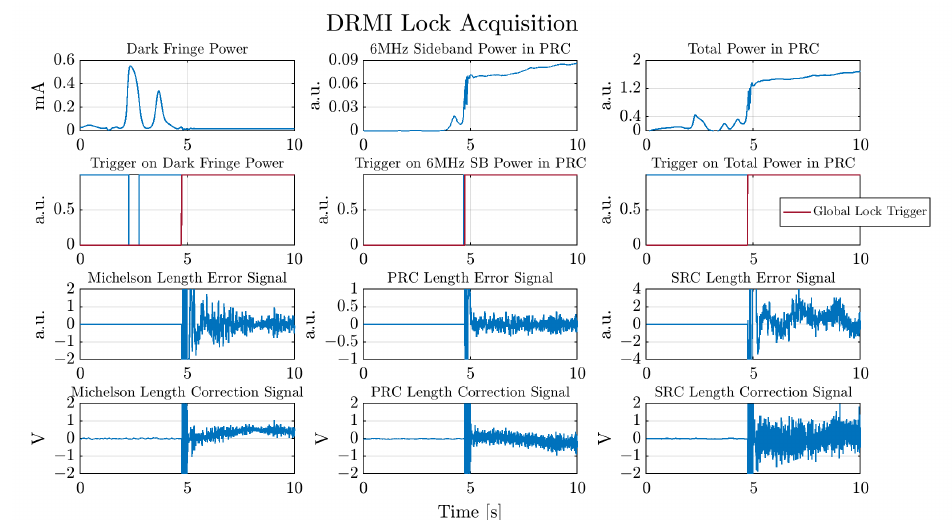
Figure 8. Example of DRMI lock acquisition during the commissioning of AdV+. In the second row there are, in blue, the three single trigger signals, based on the corresponding signals of the first row; in red, the final global trigger, computed as the product of the single